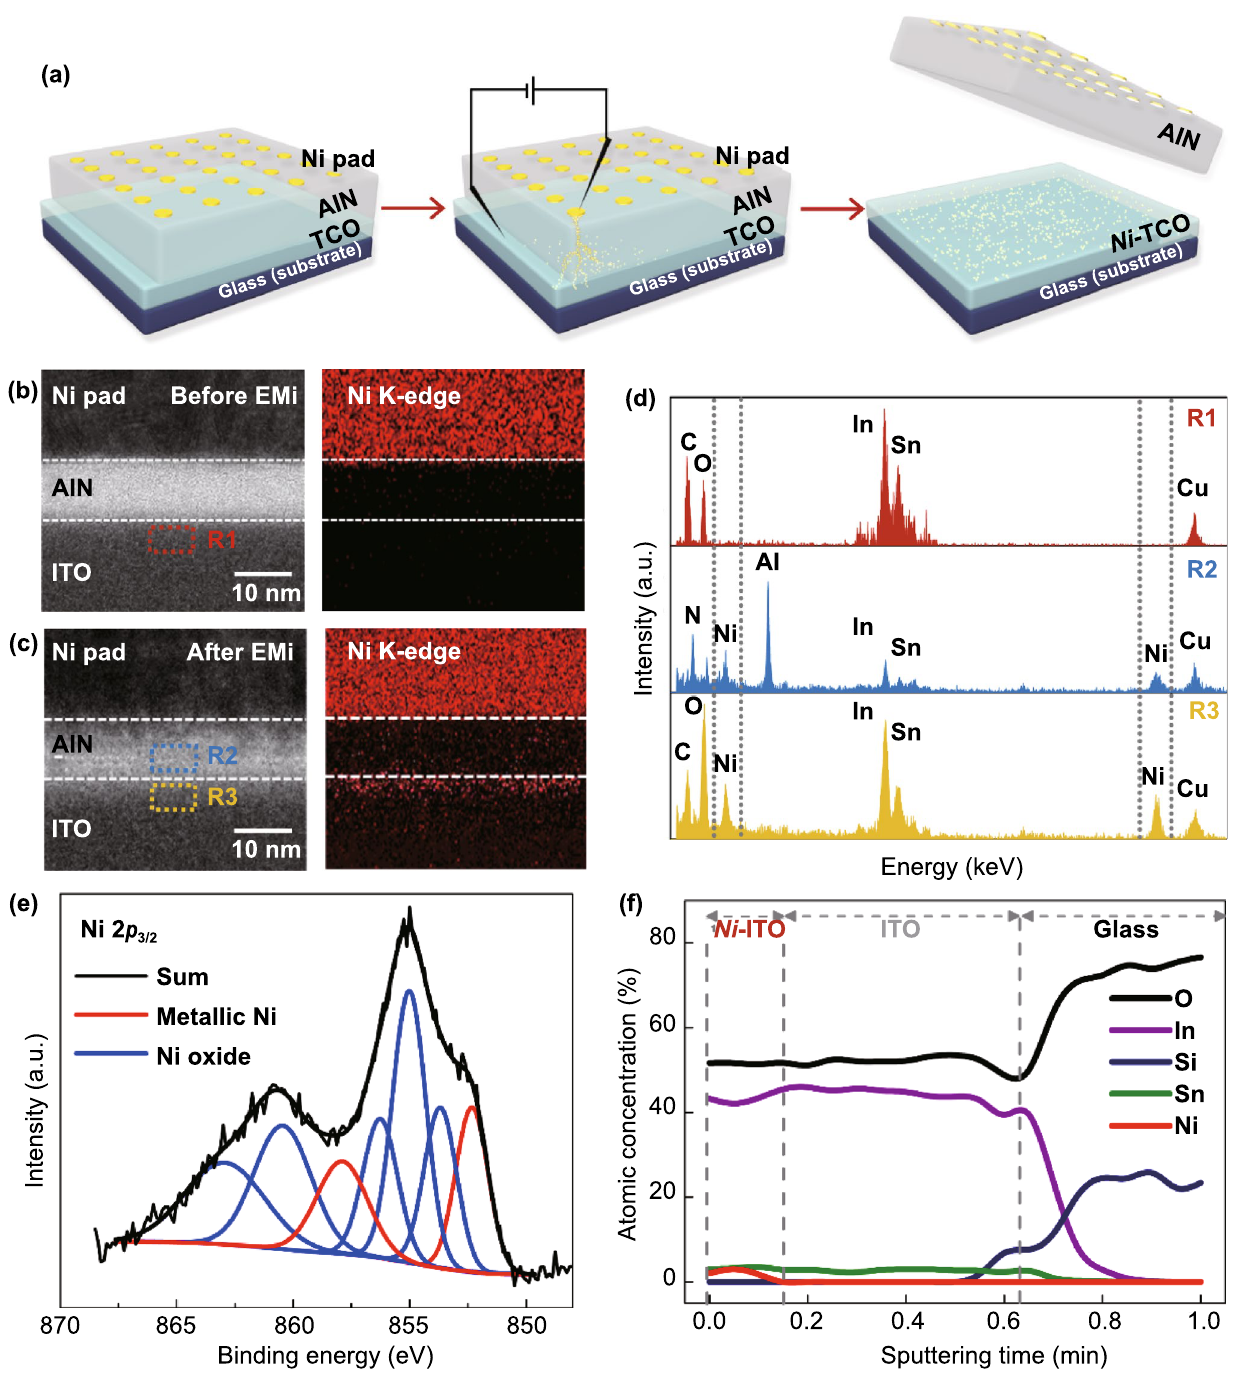
Fig. 1 Metal implantation on the surface of TCOs: a Schematic of EMi process. HR‑TEM images and Ni EDS mapping images b before and c after EMi. d EDS spectra measured at R1, R2, and R3 in Figs. 1b and 1c. e XPS core‑level spectra of Ni 2 p peaks before and after EMi. f Ni, Sn, Si, In, and O concentrations of the Ni ‑ITO films with respect to the depth from the ITO